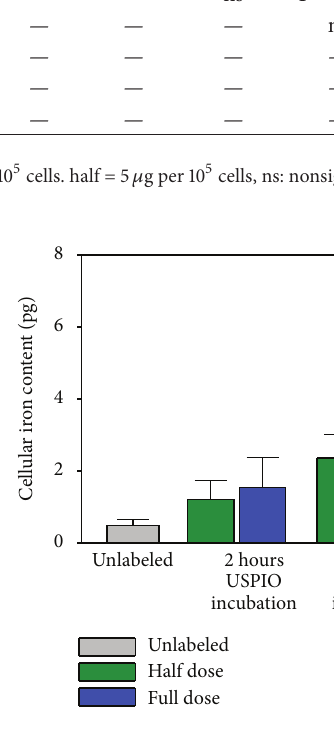
Figure 2: Cellular iron content. The iron content per cell was determined in unlabeled MSC and MSC incubated with half or full dose USPIO for 2, 6, and 21 hours. MSC: mesenchymal stromal cells. USPIO: ultrasmall superparamagnetic iron-oxide. USPIO dose— full: 10 𝜇 g per 10 5 cells; half: 5 𝜇 g per 10 5